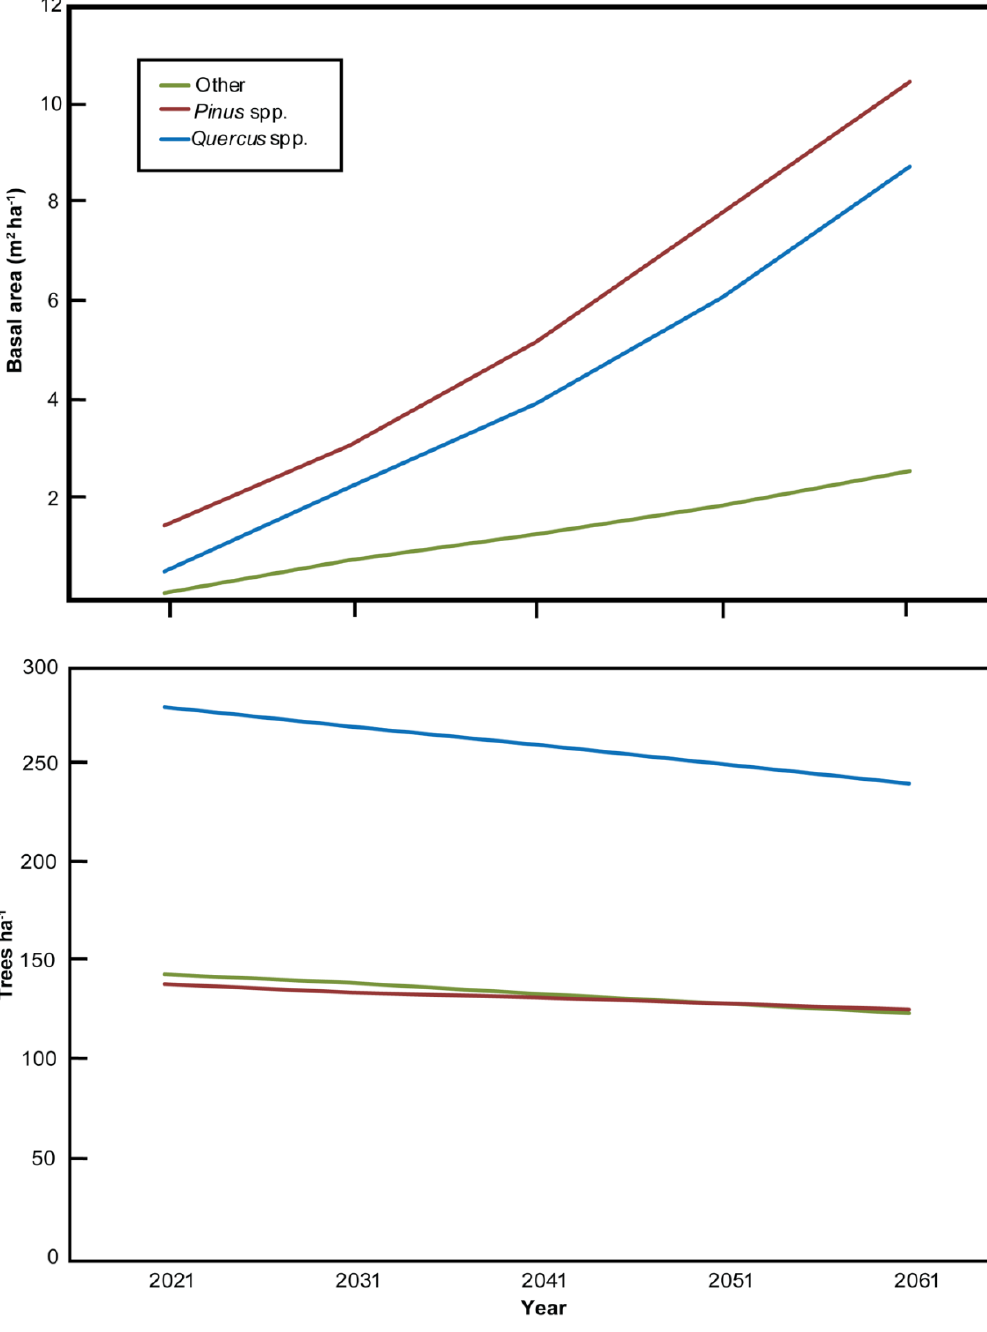
Figure 4. Forest Vegetation Simulator (FVS) model projection of tree basal area (m 2 ha − 1 ) and density (stems ha − 1 ) of Pinus spp. (red), Quercus spp. (blue) and other spp. (green) from 2021 to 2061 (stand age 50 years) in a catastrophically disturbed Pinus palustris woodland on the Oakmulgee Ranger District, Talladega National Forest, Alabama, USA.